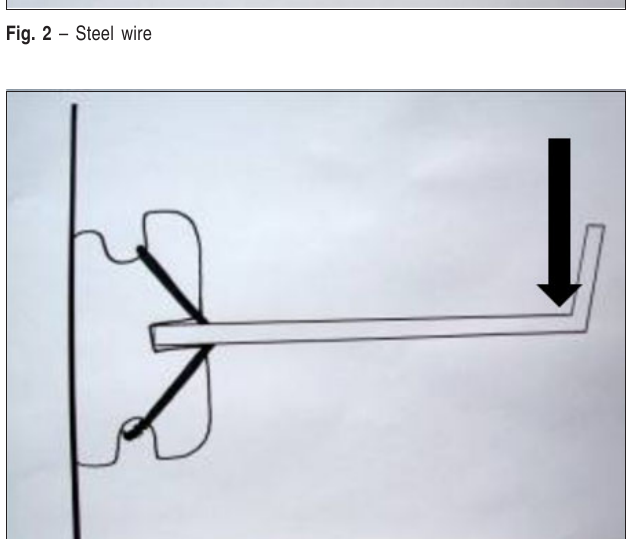
Fig. 3 – Steel wire fixed onto